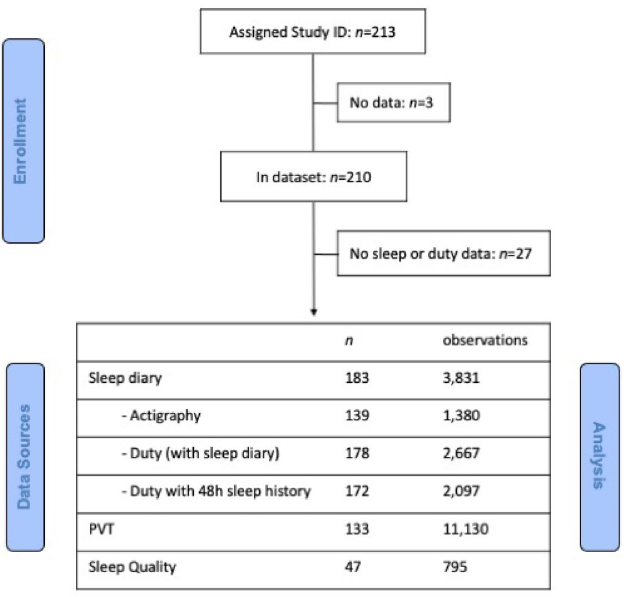
Figure 1. Consort diagram. Data flow from participant enrolment, through to number of observations for analysis for each variable. Note: Observations for Actigraphy, Duty (with sleep diary), and Duty (with 48 h sleep history) are nested within the Sleep diary sample. Sample sizes provided for PVT and Sleep Quality are independent. PVT=Psychomotor Vigilance Task.